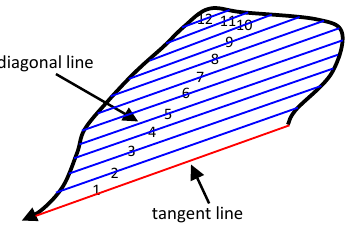
Figure 7. The inside space of U-shaped curve is divided into parts with diagonal lines along the direction of its tangent line.